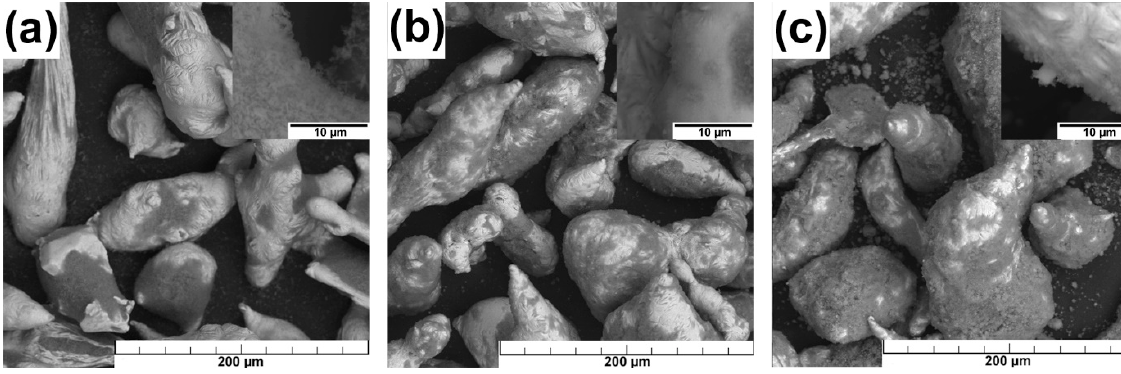
Figure 2. Morphology of ( a ) Zn-4MO, ( b ) Zn-4HA and ( c ) Zn-8HA mixtures after the homogenization process. Table 3. Phase composition of the powder mixtures according to XRD.